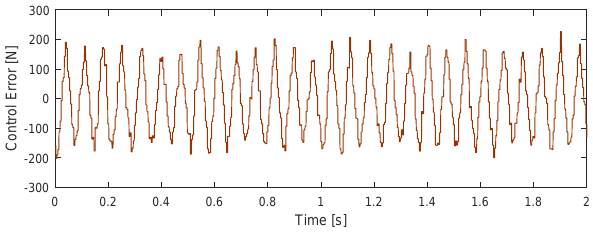
Figure 12: Limit cycle oscillations in the absence of ex- ternal velocity disturbances.